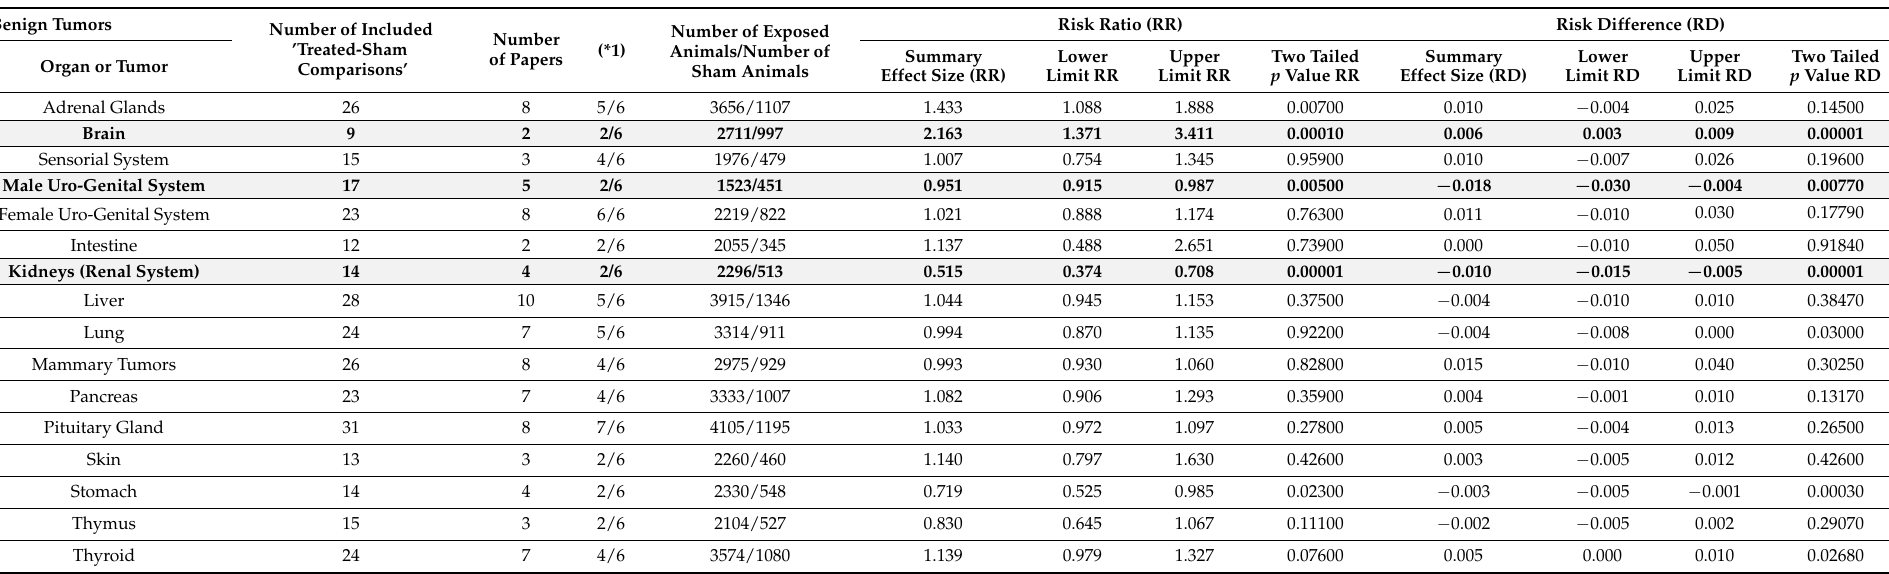
Table 4. Summary table of meta-analysis results carried out by “organ/benign tumor”: for each sample both RR and RD with the relative limits of variability (CI 95%) and p -value are reported. Statistically significant results are highlighted in